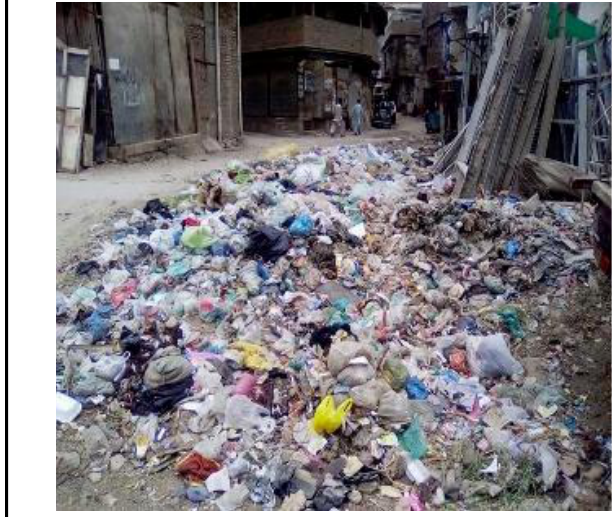
FIG. 1. LATIFABAD UNIT -6, DUMPING SITE ON